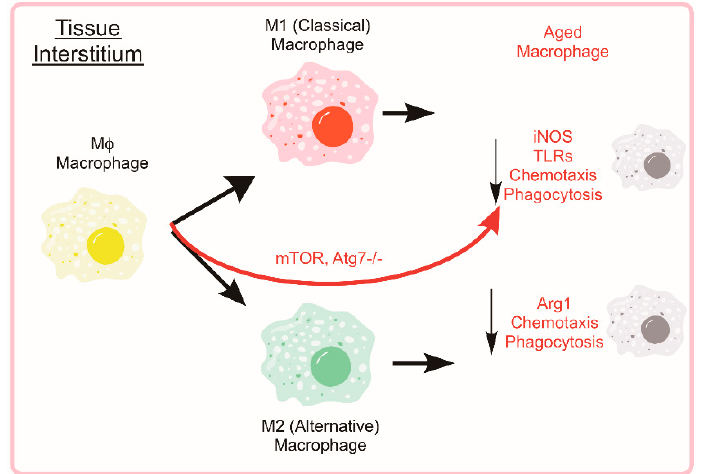
Figure 5. Aging Negatively Effects Macrophage Autophagy and Associated Phenotype/Function. The mature macrophage uses autophagy as part of the cell’s inherent function to phagocytose and eliminate pathogens or debris. The aged macrophages tend to have impairments in the autophagic functions, phagocytosis, and chemotaxis. While aged individuals tend to have elevated circulating inflammatory markers, aged M1 and M2 macrophages show reductions in iNOS and Arg1, respectively. By limiting autophagy through Atg7 genetic ablation or constitutive mTOR activation, M2 macrophages show a shift towards M1 cytokine secretion.